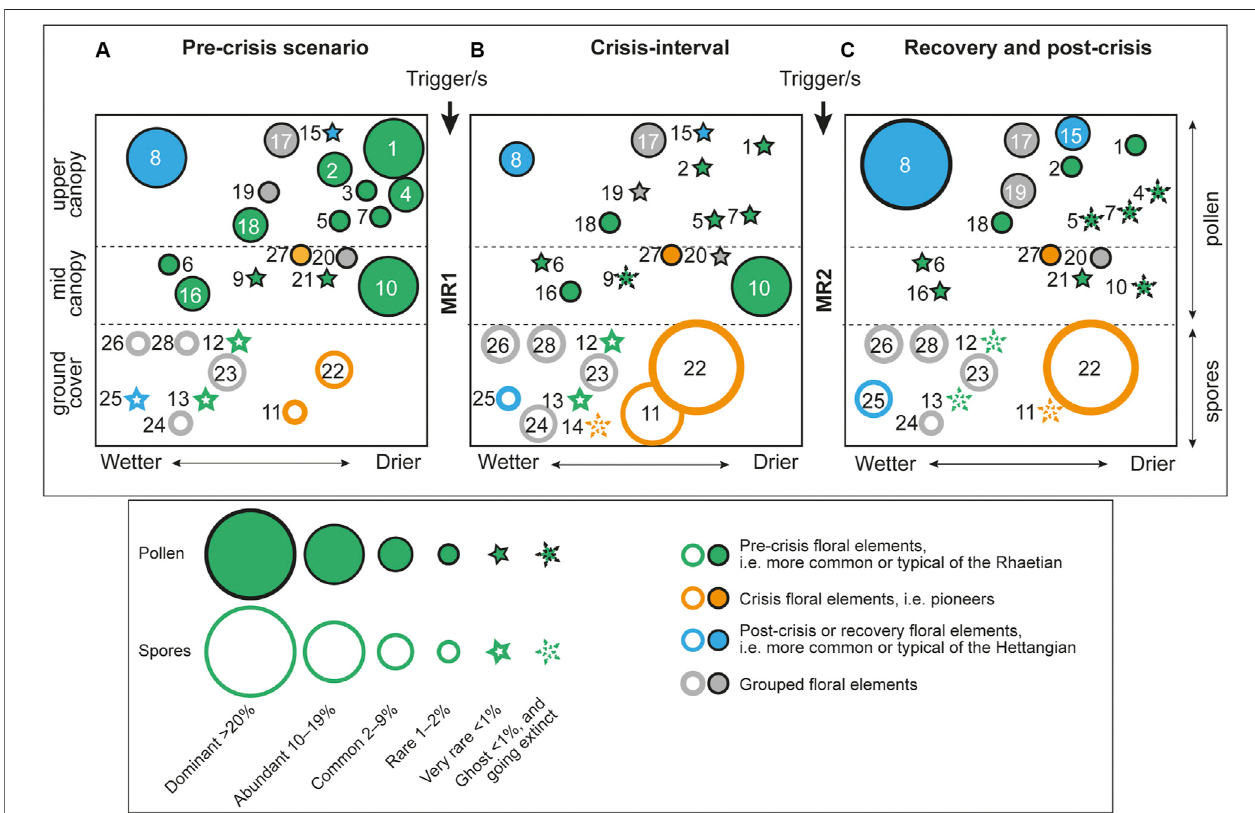
FIGURE 3 | Schematic bubble diagrams illustrating vegetation composition in the Danish Basin during (A) the pre-MR1 interval, (B) the fl oral crisis interval, (C) the post-MR2 and recovery interval, based on mean relative spore-pollen abundances in Stenlille-1. Numbers in the diagrams refer to twenty-eight speci fi c spore-pollen taxa, namely: 1. Classopollis classoides , 2. Classopollis meyerianus , 3. Geopollis zwolinskai , 4. Granuloperculatipollis rudis (all cheirolepidiacean conifers), 5. Lunatisporites rhaeticus (seed fern of conifer); 6. Monosulcites minimus (Bennettitales); 7. Ovalipollis ovalis (voltzialean conifer); 8. Perinopollenites elatoides (taxodiacean/cupressacean conifer); 9. Rhaetipollis germanicus (unknown af fi nity); 10. Ricciisporites tuberculatus (unknown gymnosperm); 11. Polypodiisporites polymicroforatus (schizaeaceanfern);12. Cingulizonatesrhaeticus (unknownlycophyte);13. Limbosporiteslundbladiae (unknownlycophyte);14. Semiretisporisgothae (unknownlycophyte);15. Pinuspollenitesminimus (pinaceanconifer);16. Vitreisporitespallidus and V.bjuvensis (bothCaytoniales);17.Bisaccates(otherthanspeci fi ed), 18. Alisporites spp. (seed ferns), 19. Non-saccate conifers (other than speci fi ed), 20. Monosulcate non-conifer pollen (other than speci fi ed), 21. Eucommiidites spp. (Erdtmannithecales), 22. Deltoidospora spp. (dipterid and matoniacean ferns), 23. Fern spores (other than speci fi ed), 24. Lycophytes (other than speci fi ed), 25. Calamospora spp. (Equisetales), 26. Bryophytes, 27. Chasmatosporites spp. (Ginkgo or Cycads), and 28. Osmundacidites/Baculatisporites/Punctatisporites spp. (osmundacean ferns). Mean abundance values can be found in Table 2